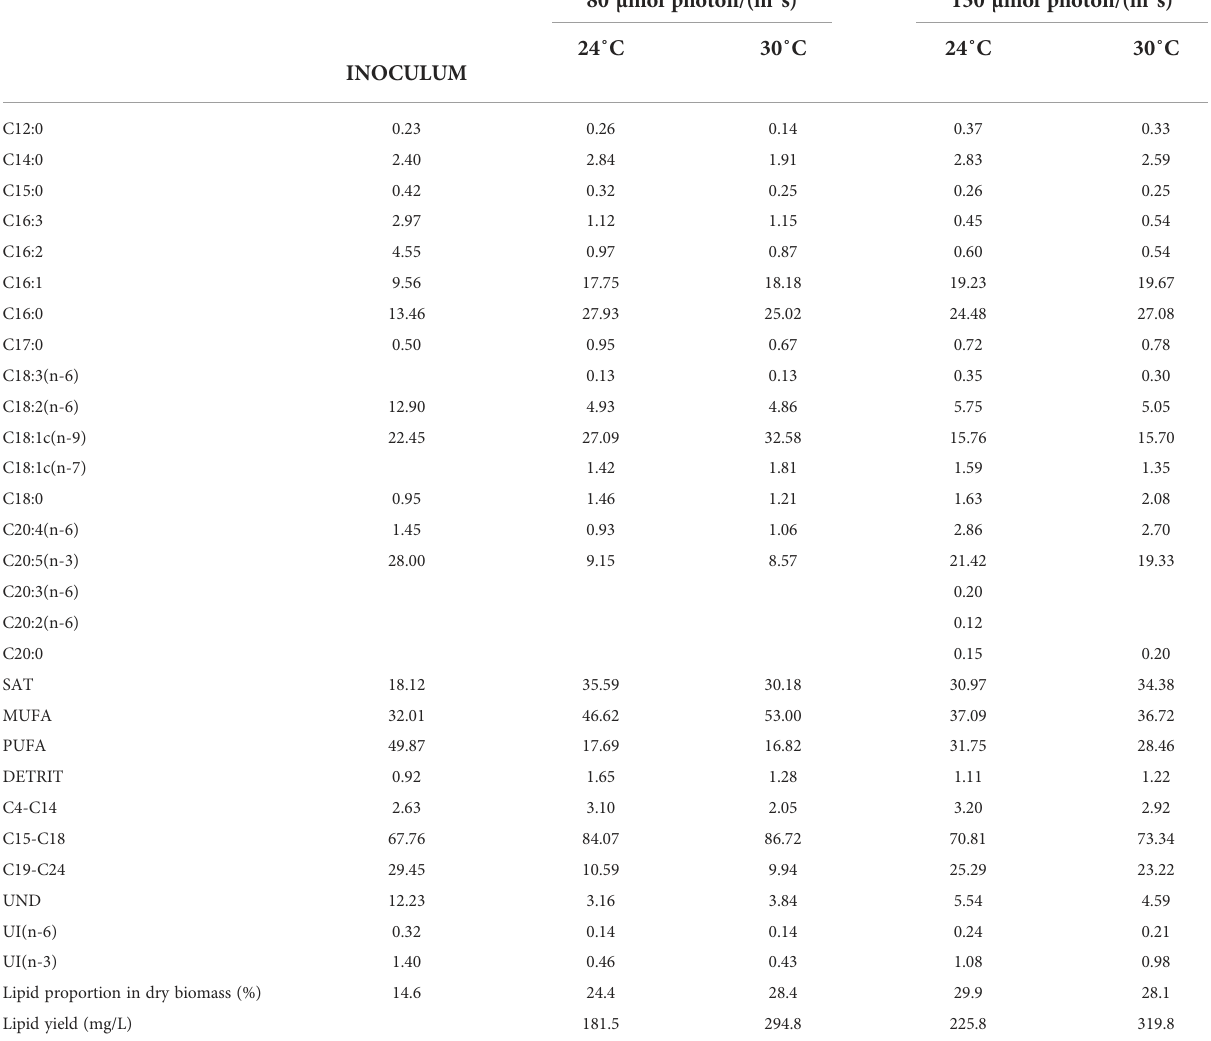
TABLE 3 Total lipid content, fatty acid pro fi le and relevant FAME classes ’ proportion of P. wilhelmii biomass grown under 24°C and 30°C; c(DIN) = 1.3 mmol/L; light levels 130 µmol phot/(m 2 s) and 80 µmol phot/(m 2 s), and diurnal (12:12) light